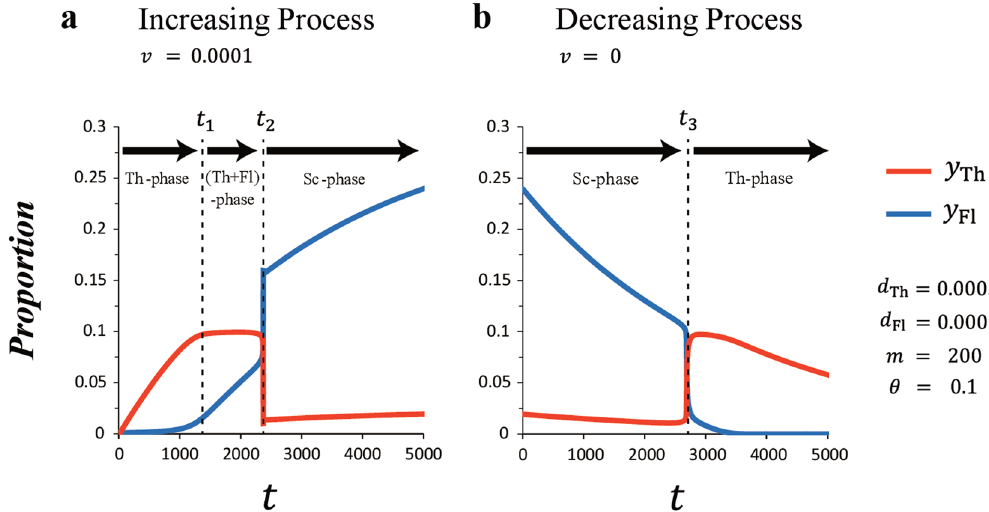
Figure 2. Population dynamics of territory holders and floaters within territorial competition. Model parameters are d Th = 0.0003, d Fl = 0.0003, m = 200 and θ = 0.1. The time step t is arbitrary. The red (blue) lines denote the proportion of territory holders (floaters). ( a ) Result in increasing stage. In this process, y Th (0) = y Fl (0) = 0 and v = 0.0001. The final time step T is 5000. The phases transit as Th → (Th + Fl) → Sc as follows. When 0 < t < t 1 , all fish can hold their own territories in rapids at low proportion. When t 1 < t < t 2 , all territory sites are occupied ( y Th = 0.1), and surplus fish become floaters. When t 2 < t , all fish give up their own territories and form a school. ( b ) Result in decreasing stage. In this process, y Th|dec. (0) = y Th|inc. ( T ), y Fl|dec. (0) = y Fl|inc. ( T ) and v = 0. The phases transit as Sc → Th as follows. When 0 < t < t 3 , all fish are floaters and cannot hold their own territories. However, when t 3 < t , territories are directly reformed from the state of a